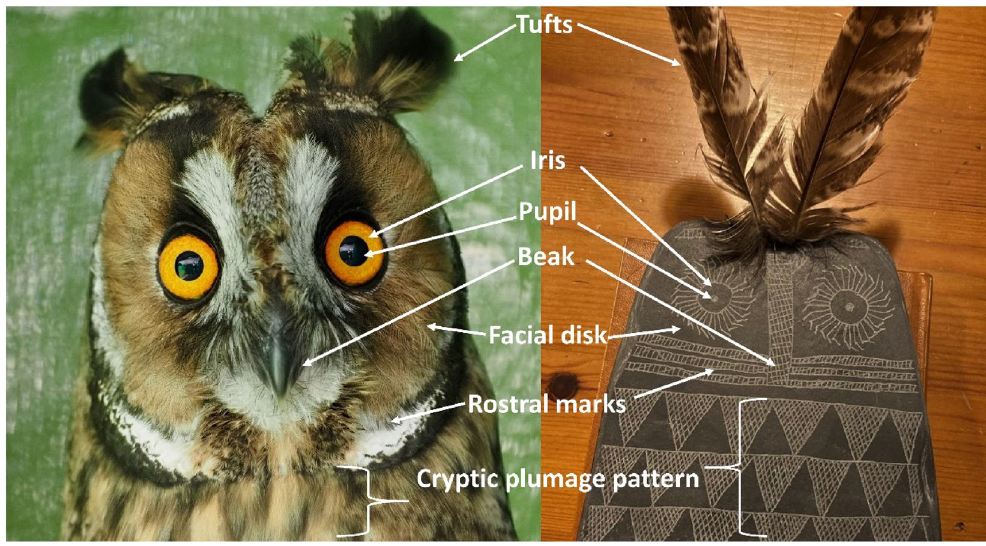
Figure 3. Correspondence of the main traits of facial and ventral areas of a long-eared owl and a feather- decorated replica of the Valencina slate plaque. Credits: Juan J.